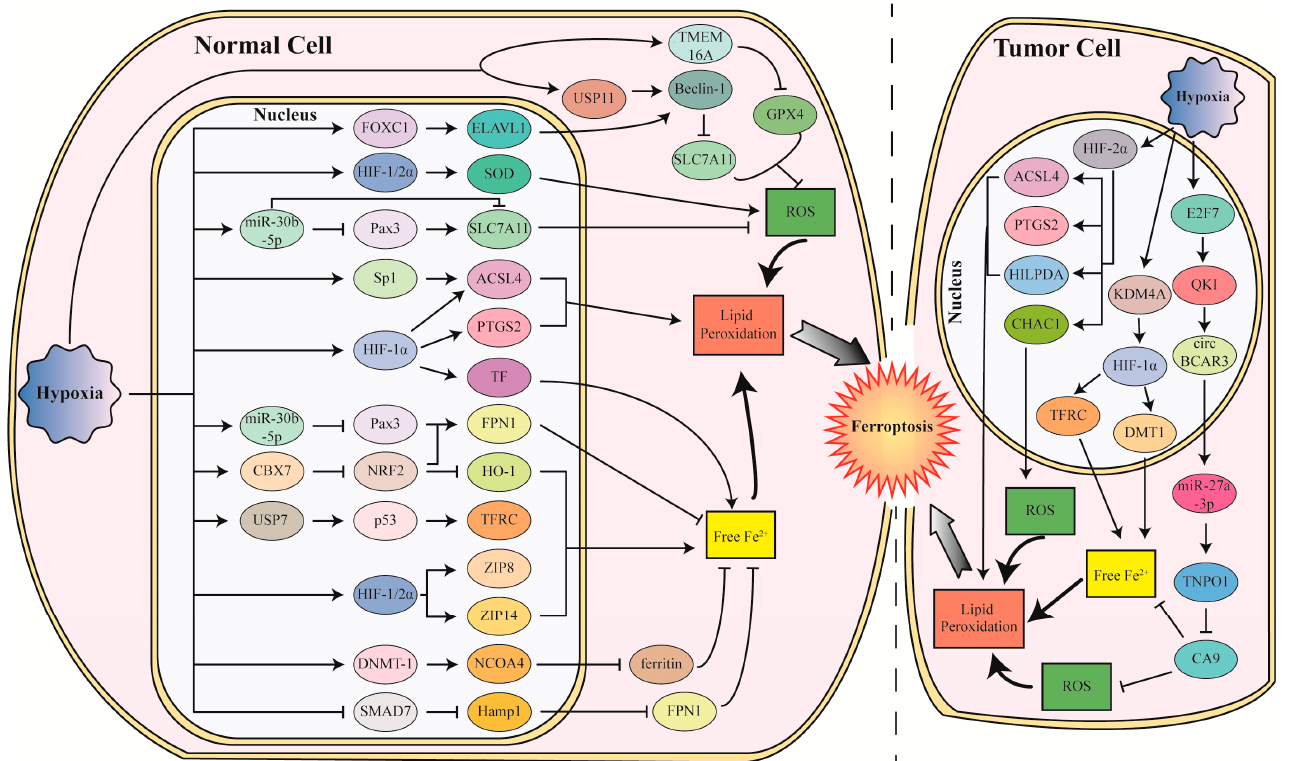
Figure 3. The mechanism of ferroptosis promoted by hypoxia, HIFs, or H/R in cells. In normal cells, hypoxia activates HIF-1 α , HIF-2 α , FOXC1, sp1, USP7, p53, CBX7, DNMT-1, USP11, TMEM16A, Beclin-1, and miR-30b-5p, and represses NRF2, SMAD7, and Pax3, to regulate SLC7A11, PTGS2, ACSL4, TF, FPN1, HO-1, TFRC, ZIP8, ZIP14, NCOA4, Hamp1, ELAVL1, SOD, GPX4, and ferritin, resulting in the induction of ferroptosis. In tumor cells, hypoxia regulates HILPDA, ACSL4, PTGS2, and CHAC1 by HIF-2 α , TFRC, and DMT1 by HIF-1 α and protein CA9 by E2F7/QKI/circBCAR/miR- 27a-3p/TNPO1 to promote ferroptosis.